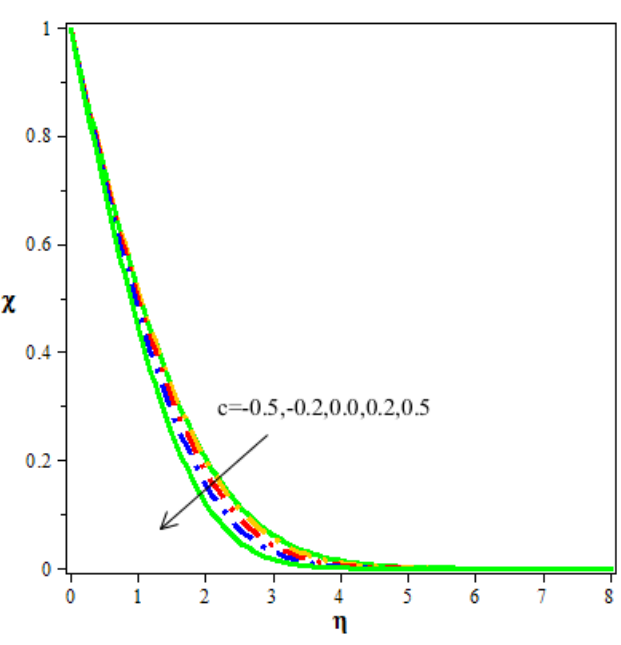
Figure 5. The curve θ ( η ) on c .